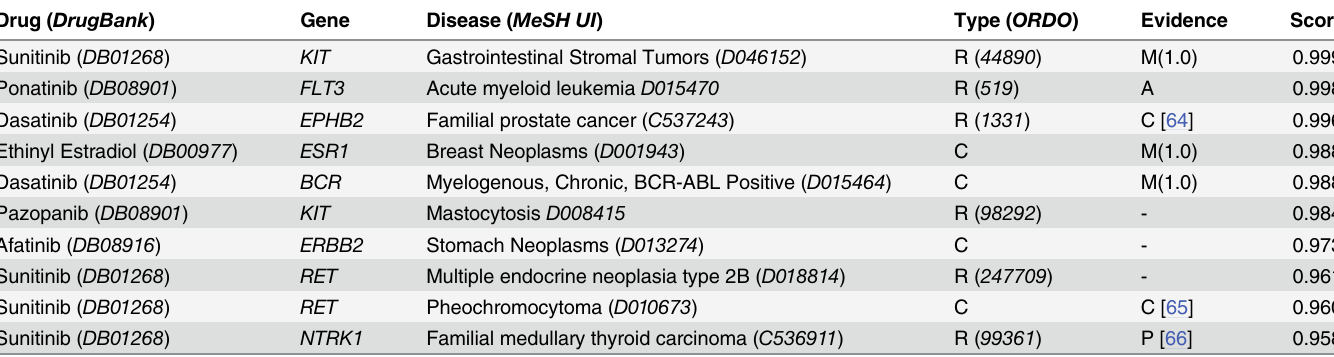
Table 4. Top 10 inferred associations involving unique neoplasm